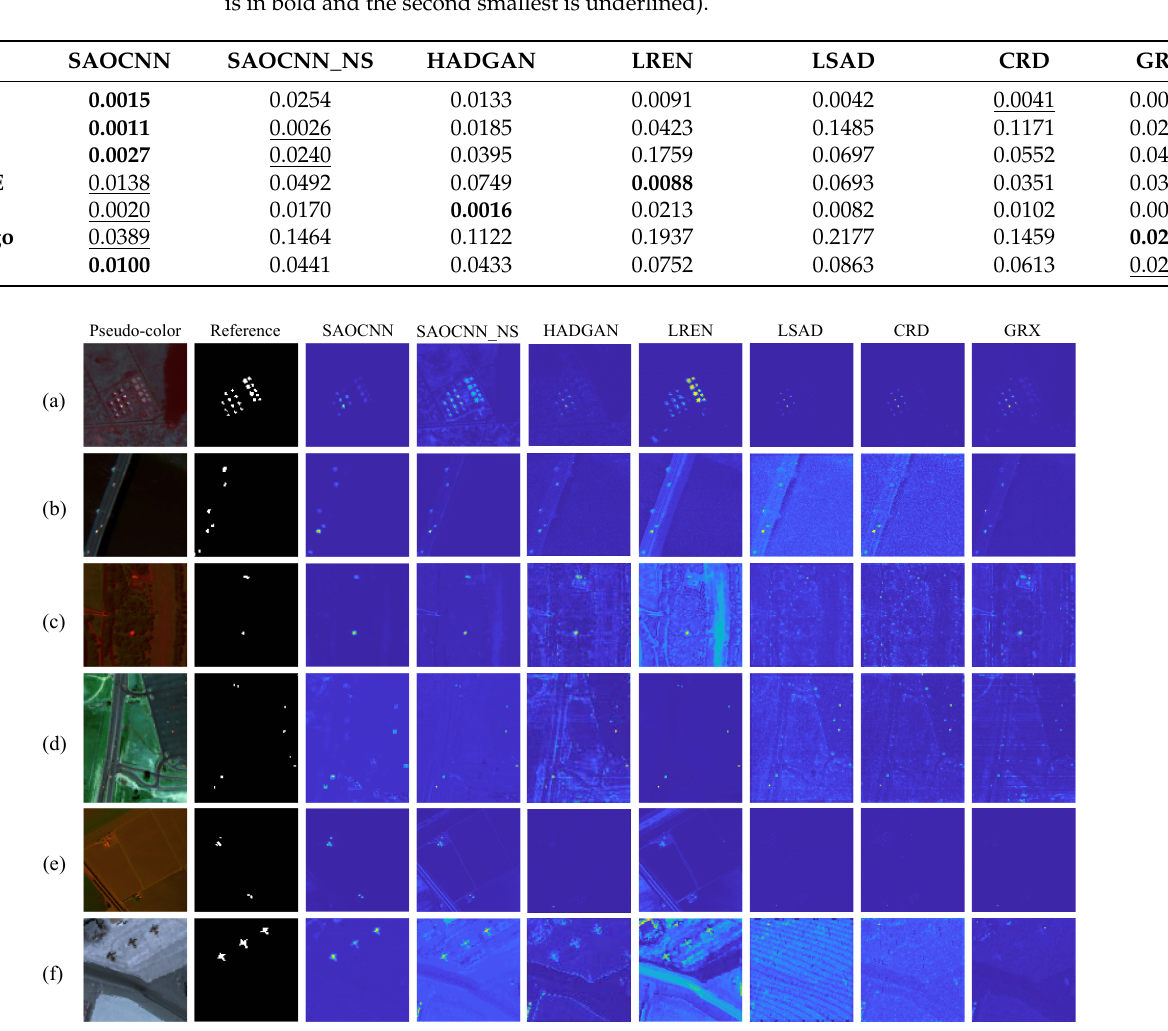
Table 2. AUC τ of SAOCNN, SAOCNN_NS, HADGAN, LREN, LSAD, CRD, and GRX. (The minimum is in bold and the second smallest is underlined).